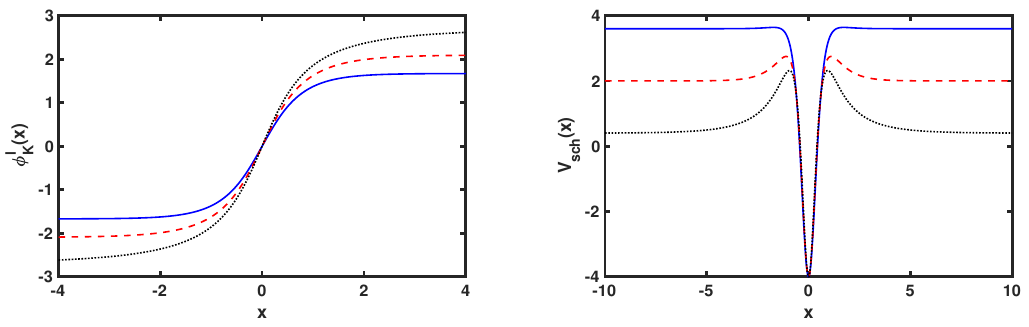
Figure 2 . (a) Large kink solutions φ l ( x ) and (b) corresponding Schrödinger-like potential V sch ( x ). K In both figures we fixed r = 0 . 1 (blue solid), r = 0 . 5 (red dash), r = 0 . 9 (black